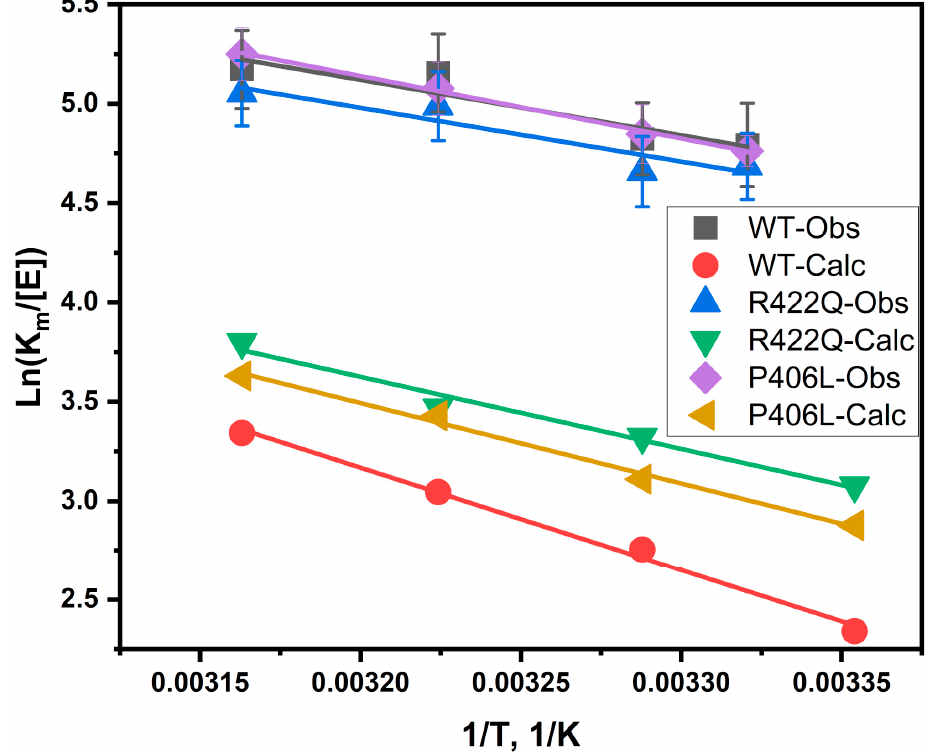
Figure 4. The Van’t Hoff plots of WT and mutant variants. Experimental (Obs) and calculated (Calc) data are shown for WT, R422Q, and P406L, respectively. These plots were derived from the fitting of the temperature-dependent kinetics data of the diphenol oxidase reactions and computational association data. All experiments were performed in duplicates and error bars represent standard deviations.